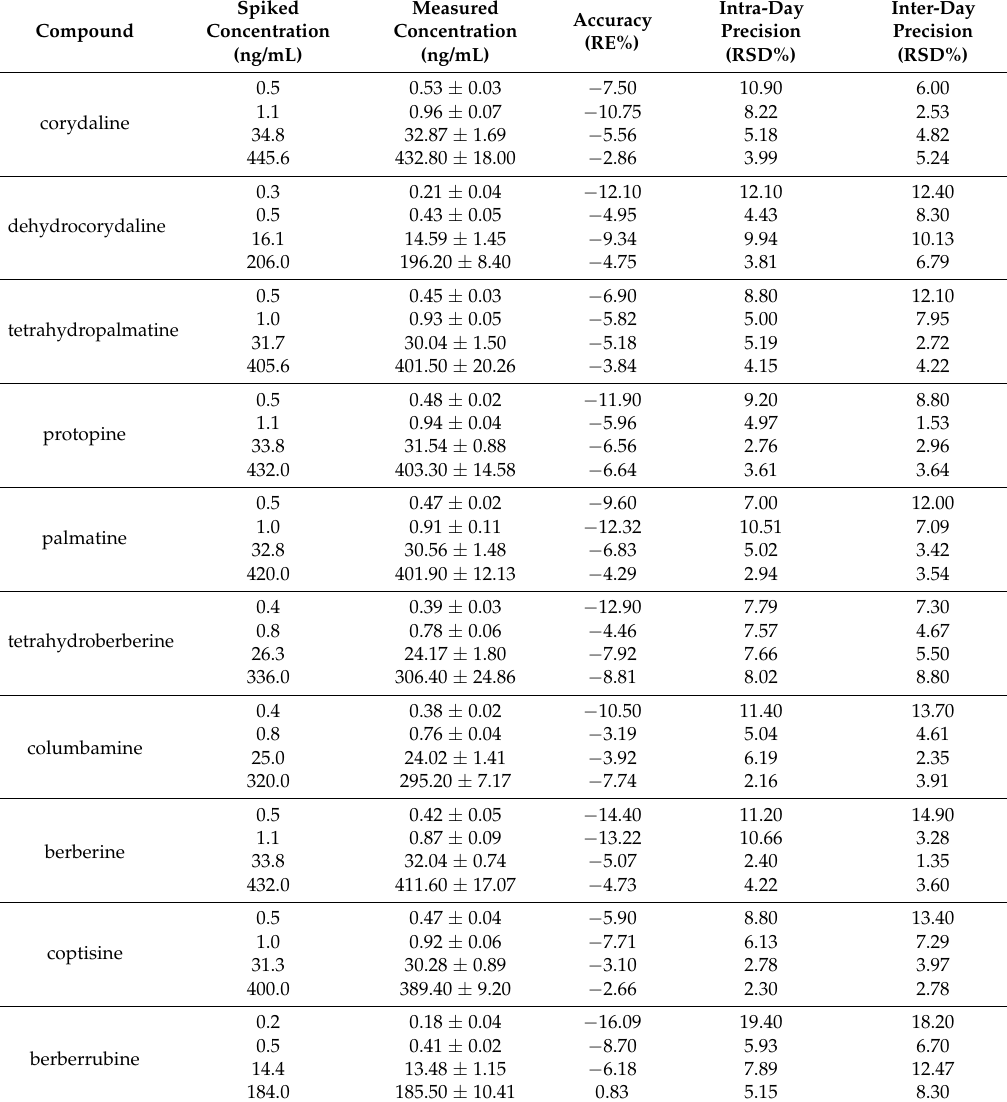
Table 2. Precision and accuracy of the determination of the 10 alkaloids in the beagle dog plasma ( n = 18, six replicates per day for three